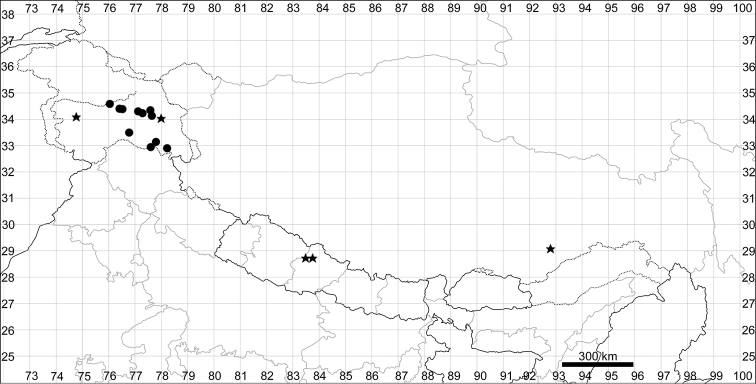
Distribution map of Bassiascoparia (stars) and B.odontoptera (circles).